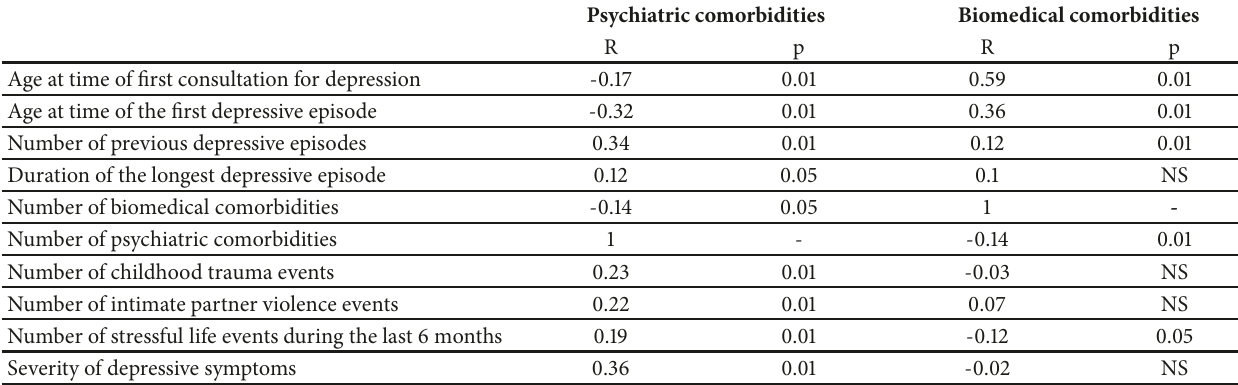
Table 3: Correlations between psychiatric and medical comorbidities with other variables of the study in 394 primary care patients with depression, Maule region, Chile,